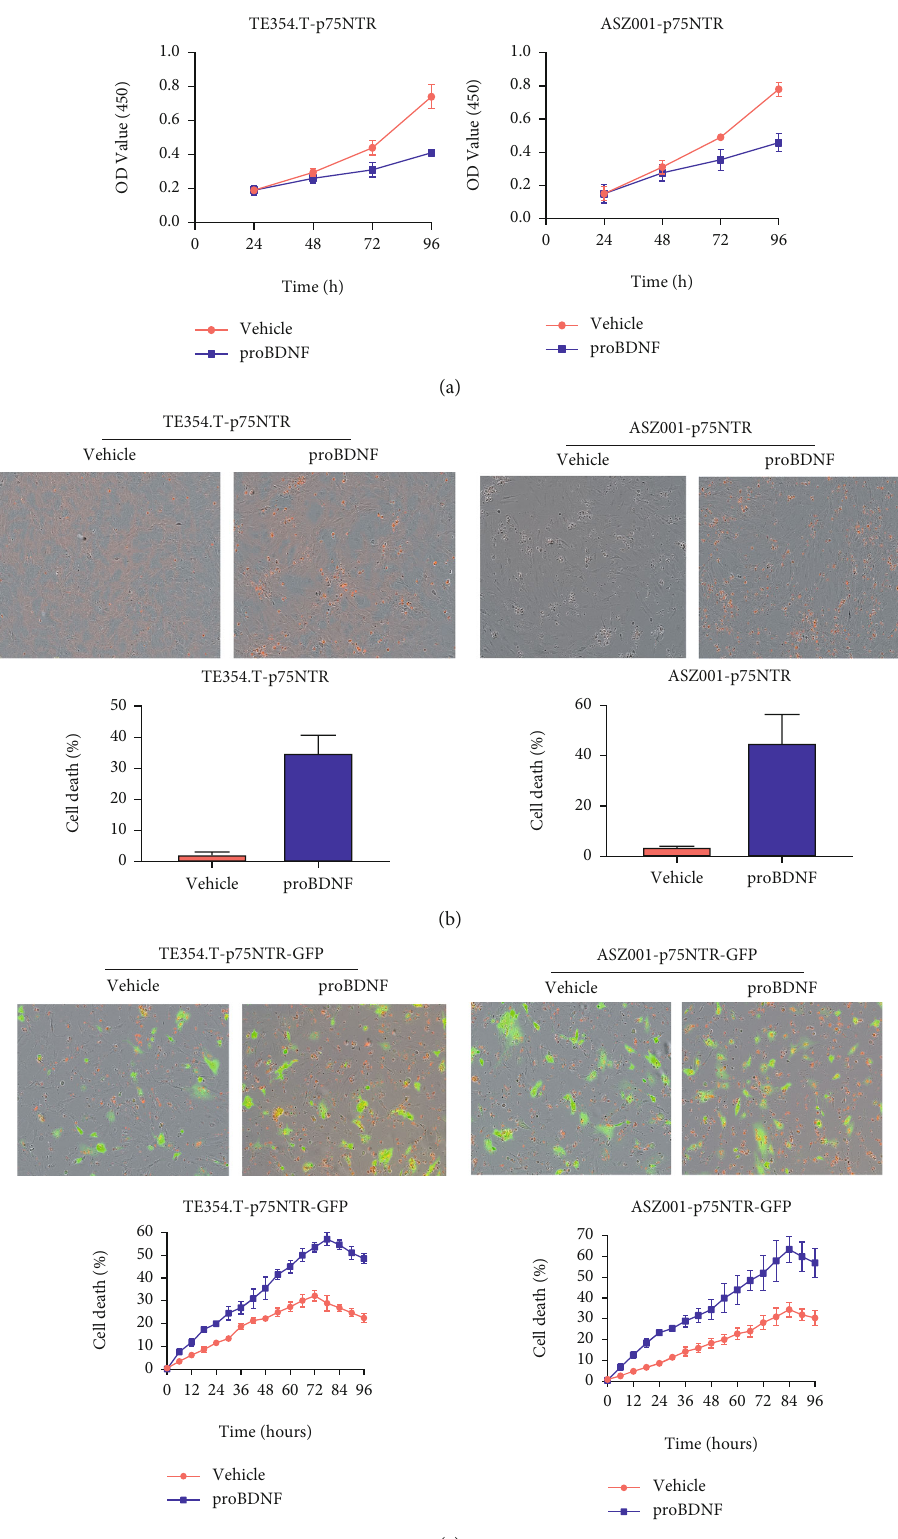
Figure 2: p75NTR/proBDNF regulates BCC cell proliferation and cell death. BCC cells stabilized expressed p75NTR recombinant GFP were treated with proBDNF. Cell proliferation was determined by MTT assay. (b) Cell death (apoptosis) was tracked by staining with Annexin V/PI kit. (c) Cell death (necroptosis) was tracked by staining with cytotoxic